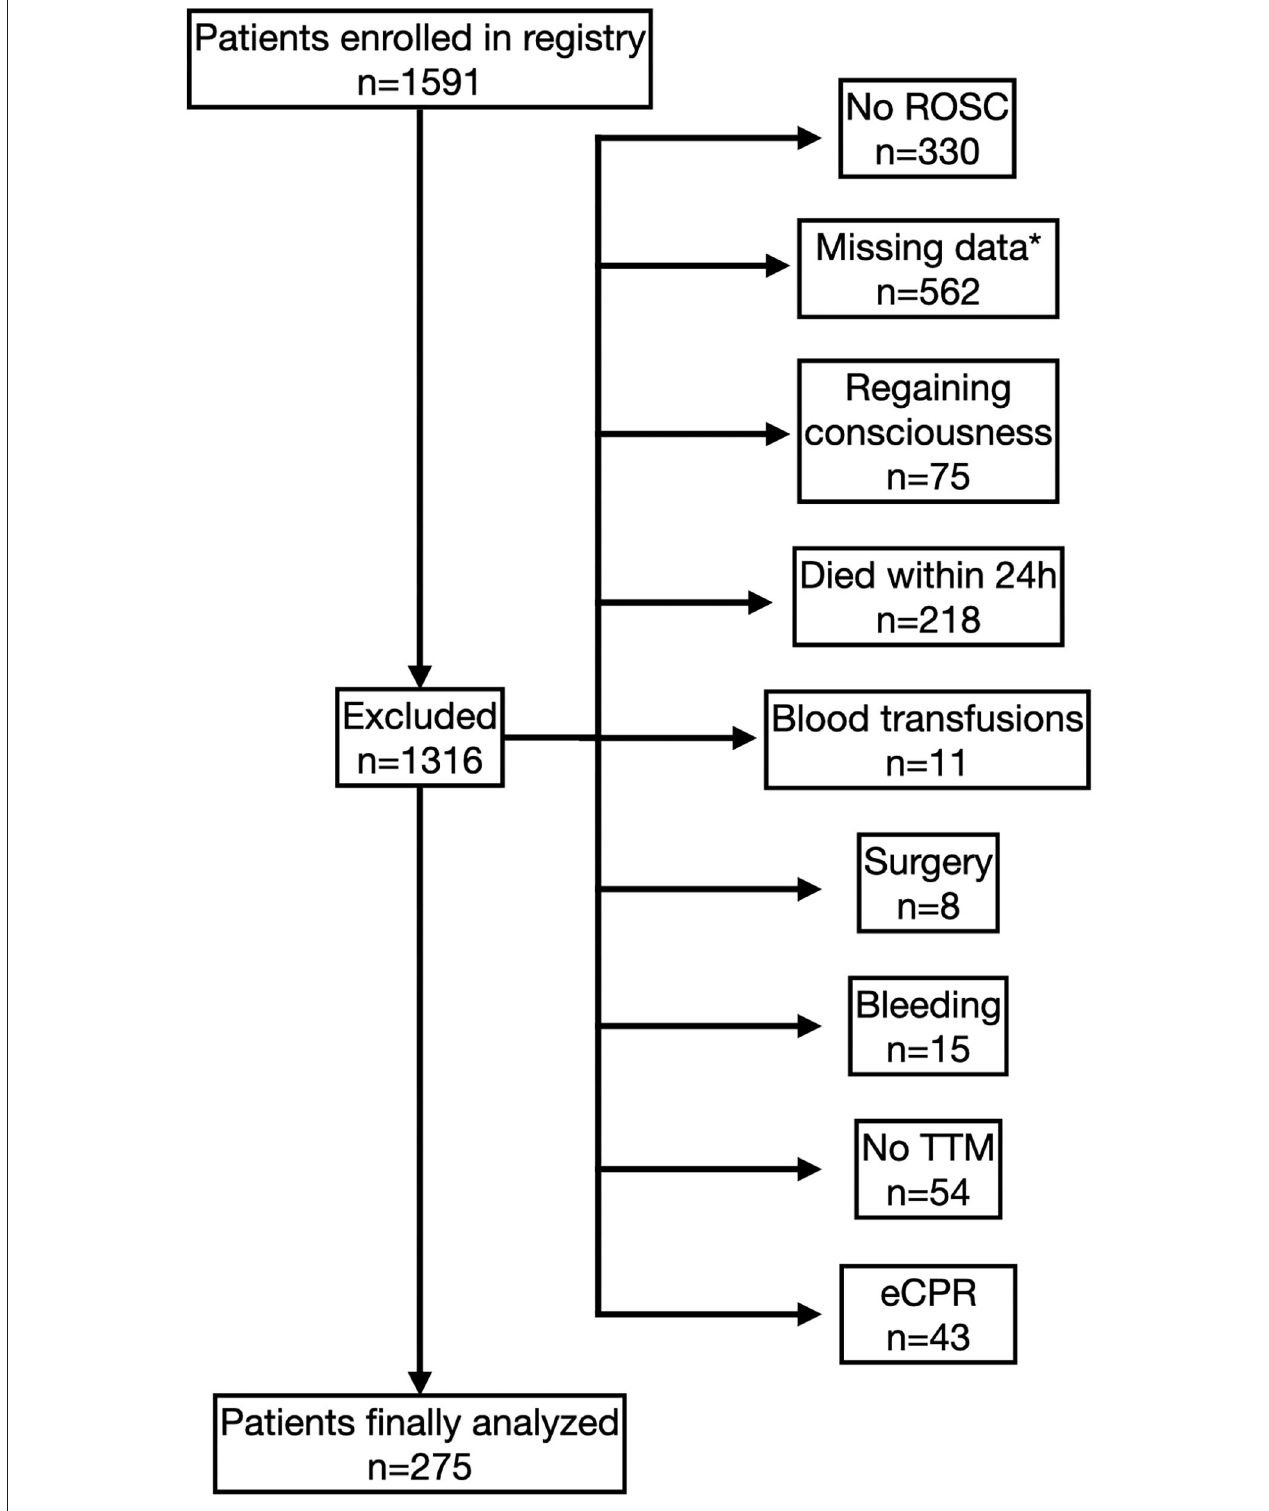
FIGURE 1 | Study flow chart. Flow diagram of enrolment and exclusion of patients. *Only patients with full datasets for multivariable analyses were eligible.